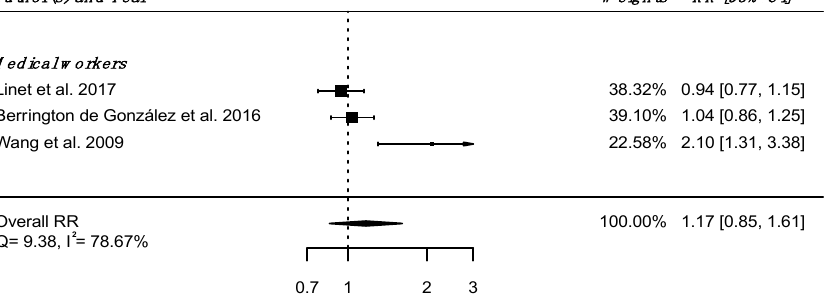
Figure 3. Relative risk (RR) and 95% confidence interval (CI) for mortality from diseases of the nervous system and sense organs in the reviewed studies among IR exposed populations compared with unexposed